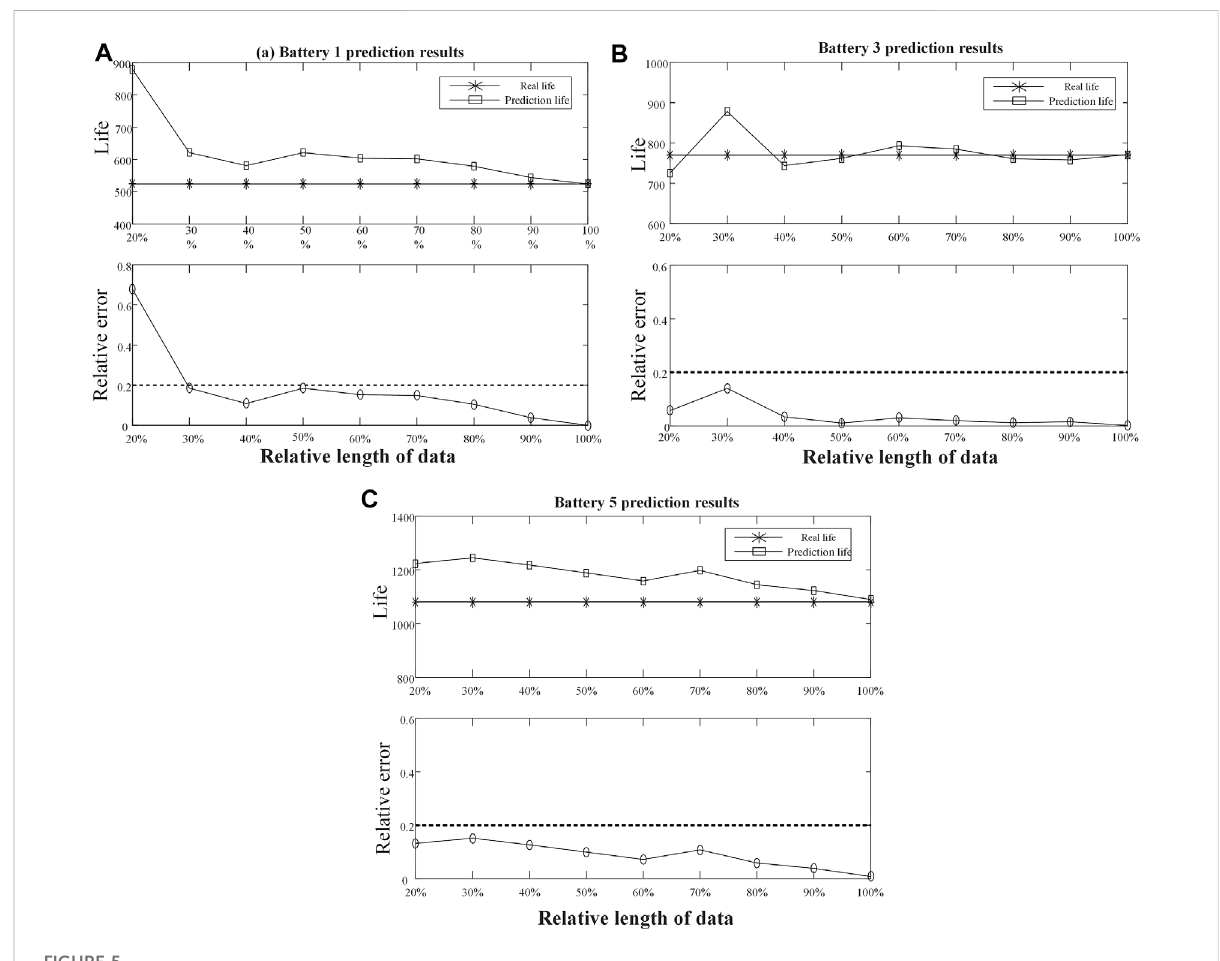
FIGURE 5 Battery life prediction results under different data